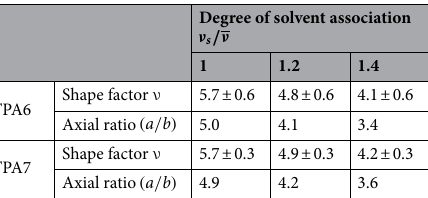
Table 3. The calculated values for the shape parameter ν and the axial ratios (prolate ellipsoid model) determined by